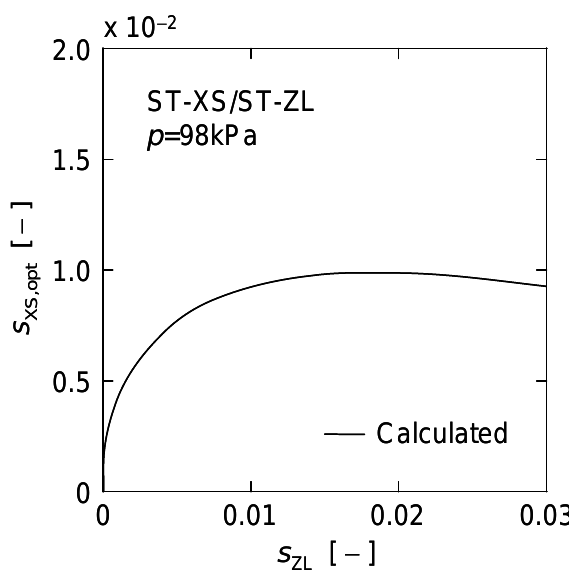
Figure 11. Optimal concentration of small particles for high filtration rate.